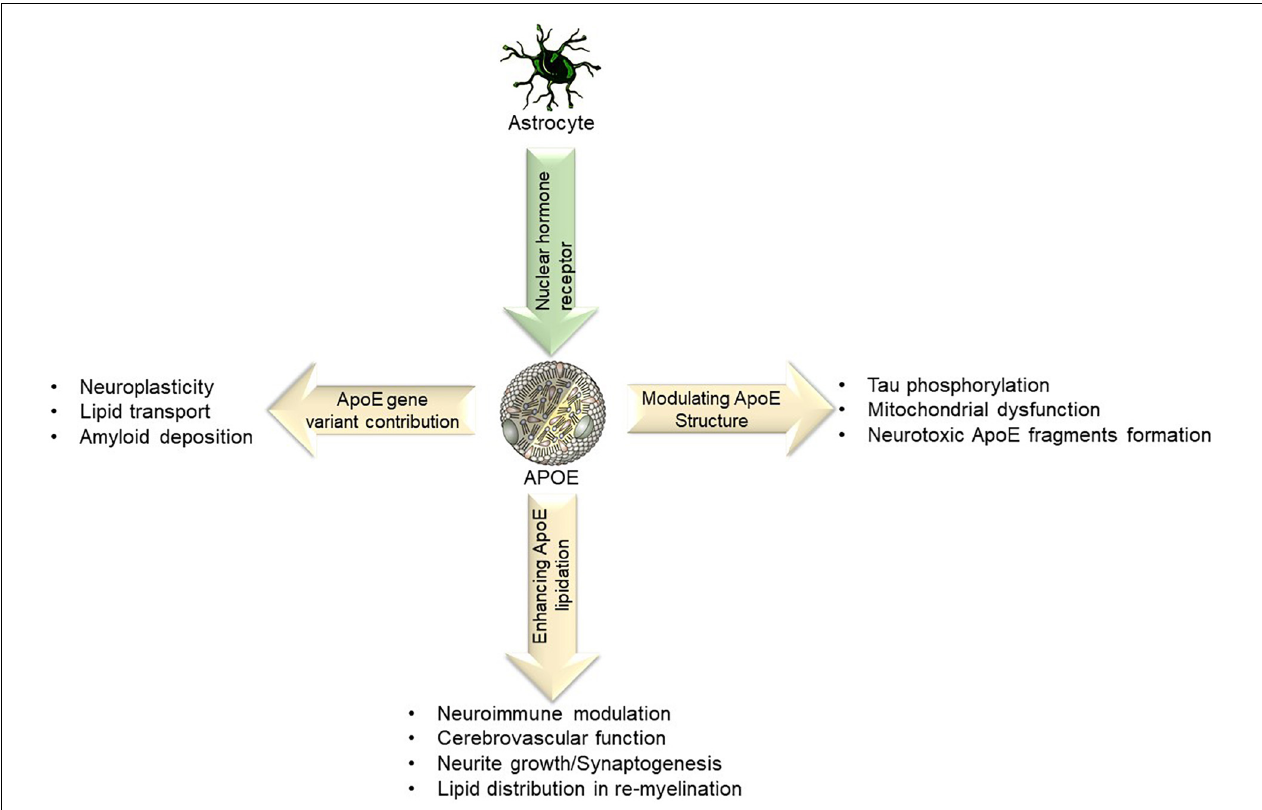
FIGURE 3 | Lipid transport refers to the ability of APOE to bind to LDL receptors and assist with lipid clearance. Certain APOE alleles also interact and affect amyloid deposition, neuroplasticity, neuroimmune modulation and in re-myelination